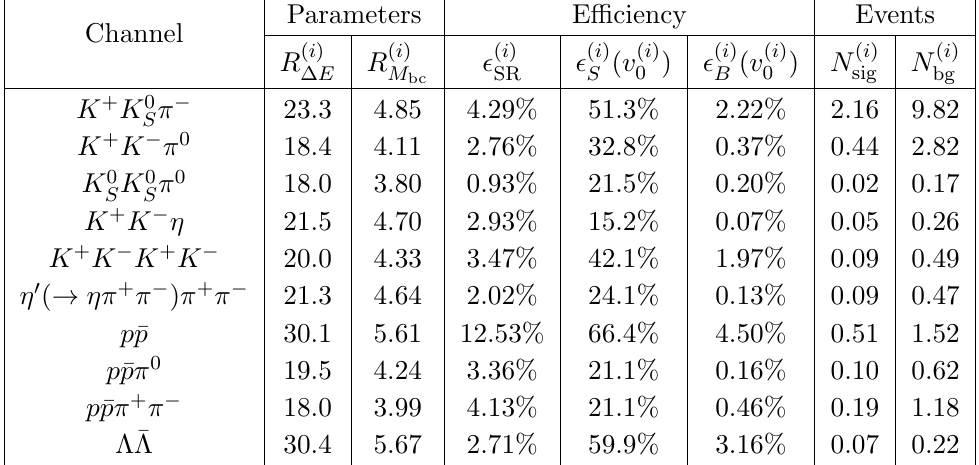
Results of the optimization of the selection requirements for the channel B +